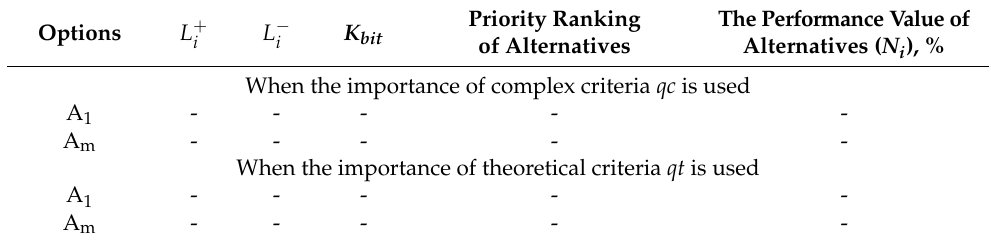
Table 16. The most rational option obtained by the TOPSIS